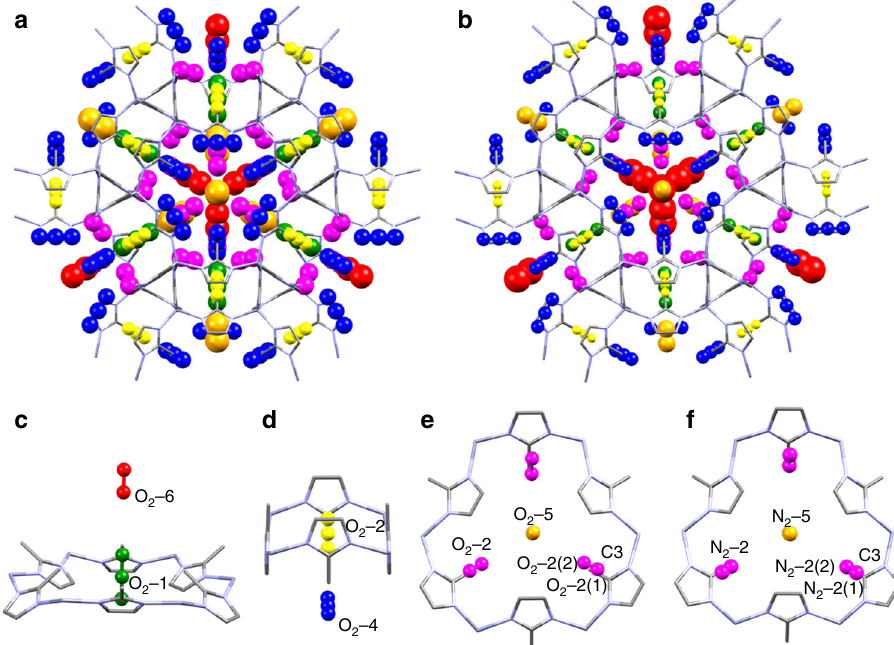
Fig. 5 Experimentally-derived unit cell of ZIF-8-HP with N 2 and O 2 adsorption sites. a Adsorbed N 2 molecules at 3.25 GPa, and b adsorbed O 2 molecules at 1.20 GPa. In a and b guest shown as ellipsoids (50% probability) and each colour represents symmetry-independent adsorption sites. c 6MR window with sites O 2 -1 and O 2 -6. d 4MR window with sites O 2 -3 and O 2 -4. e 6MR window with O 2 -2 and O 2 -5 showing O 2 (1)-O 2 -(2)- C3 angle of 130°. f 6MR window with N 2 -2 and N 2 -5, showing N 2 (1)-N 2 -(2)- C3 angle of 150°. Note as c and d N 2 analogues are similar, their structures are not represented